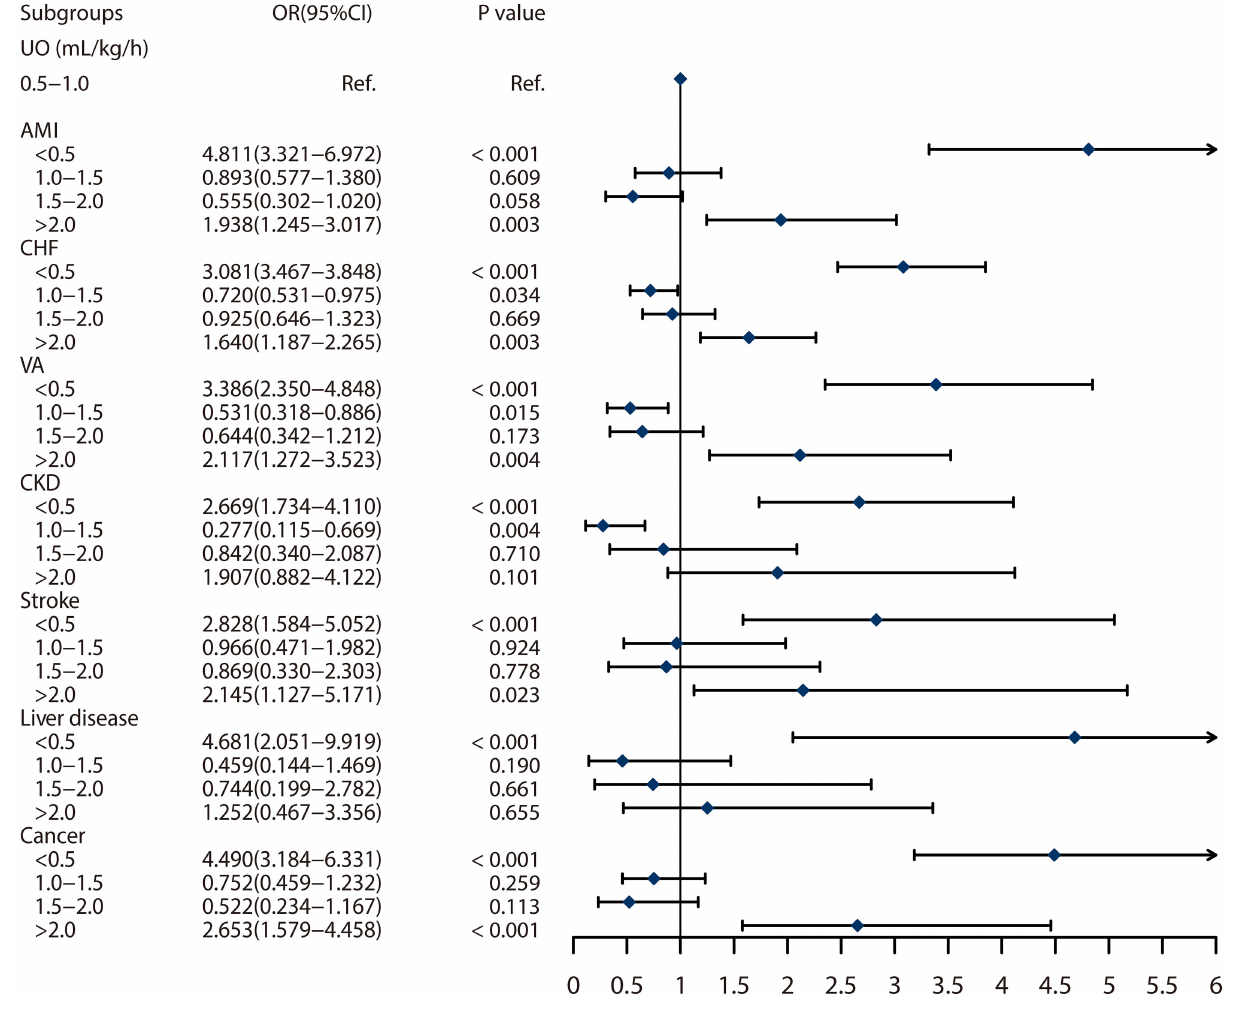
postoperative period for the cardiac surgical patients